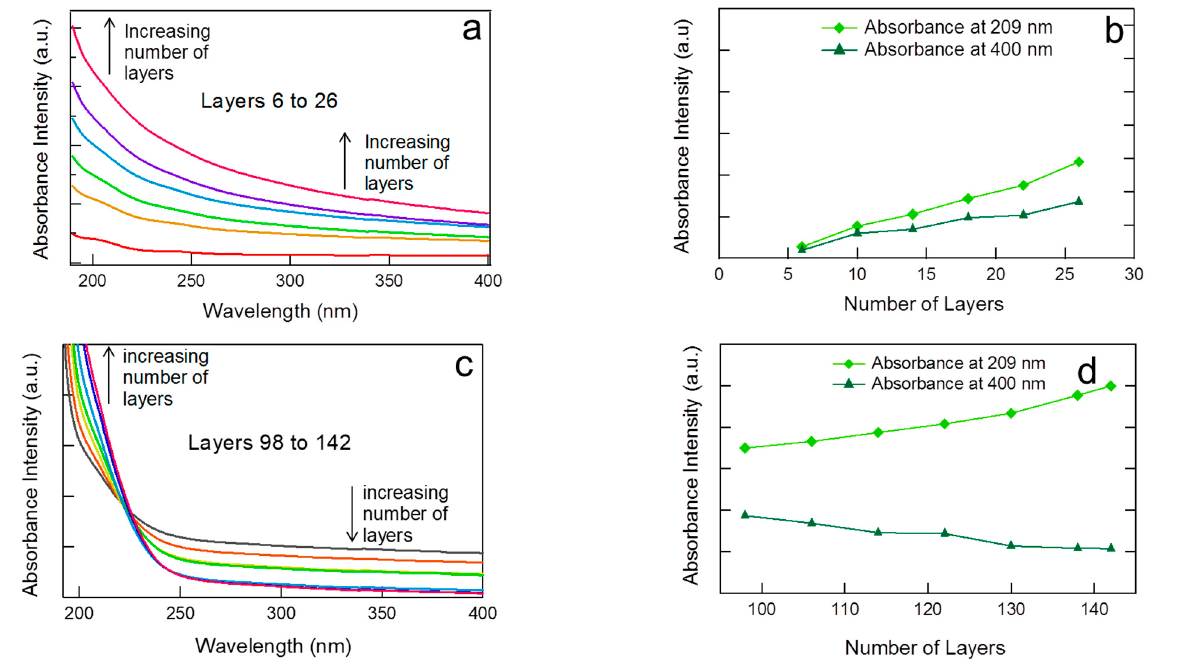
Figure 5. UV spectra of PDDA-PAA-PDDA-Laponite system; ( a ) UV spectra of multilayers for layers 6 to 26; ( b ) UV–Vis absorbance intensity at 209 nm (characteristic wavelength of PAA) and at 400 nm (visible light) as a function of the number of layers; ( c ) UV spectra of multilayers for layers 98 to 142; and ( d ) UV–Vis absorbance intensity at 209 nm and at 400 nm as a function of the number of